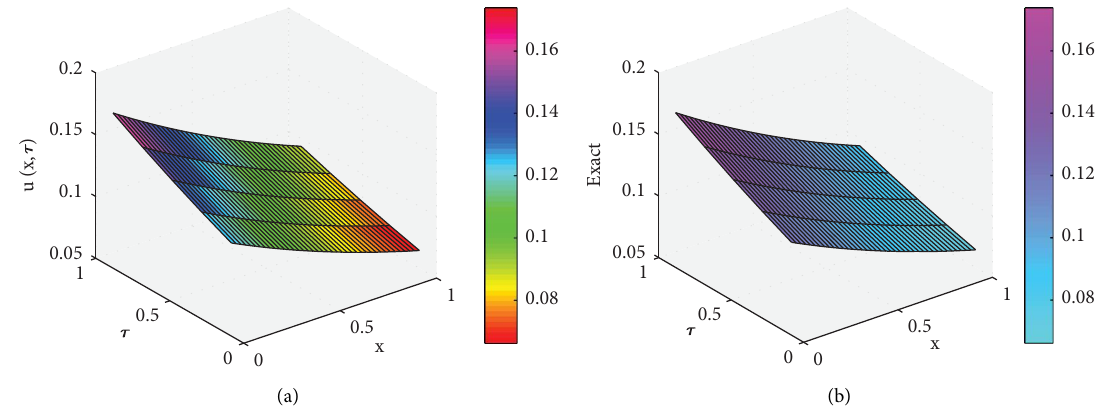
Figure 2: (a) Approximate solution and (b) exact solution of Example 1 at k � 2, M � 3.